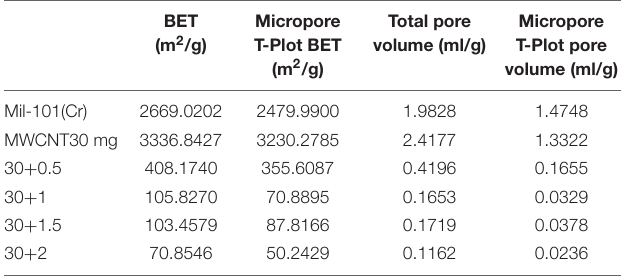
BET Micropore Total pore Micropore (m 2 /g) T-Plot BET volume (ml/g) T-Plot pore (m 2 /g) volume (ml/g)